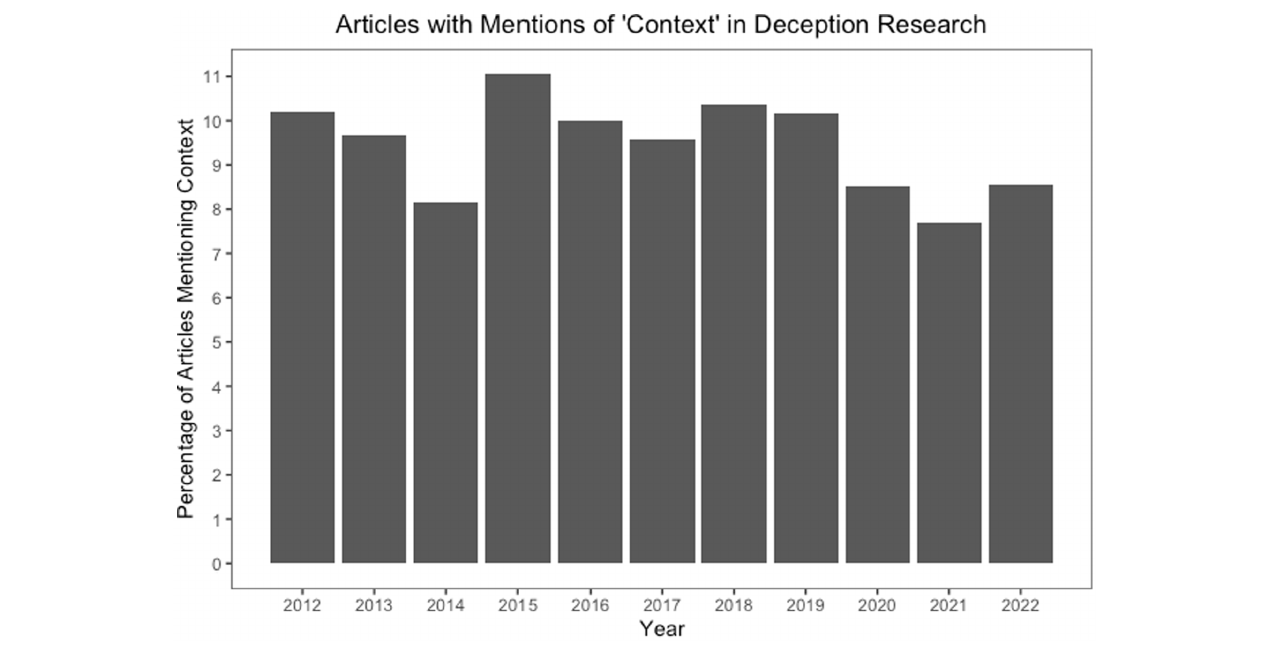
FIGURE 1 Frequency of context-related terms in the deception literature over time. The total number of articles in this analysis was